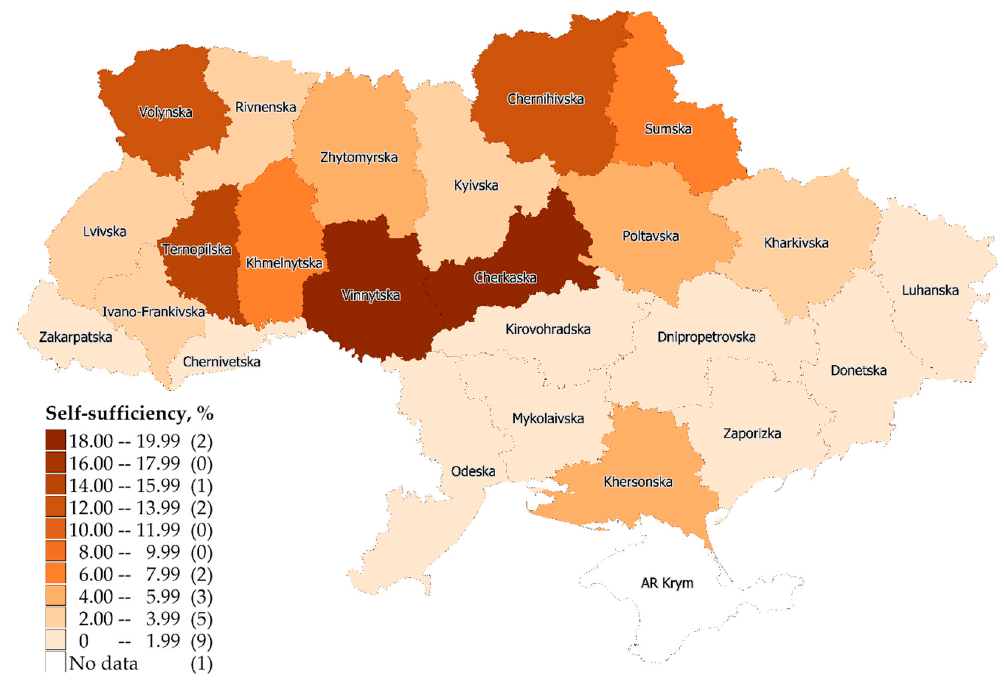
Figure 2. Potential self-sufficiency of electricity form cogeneration in agricultural biogas plants. Source: own research.